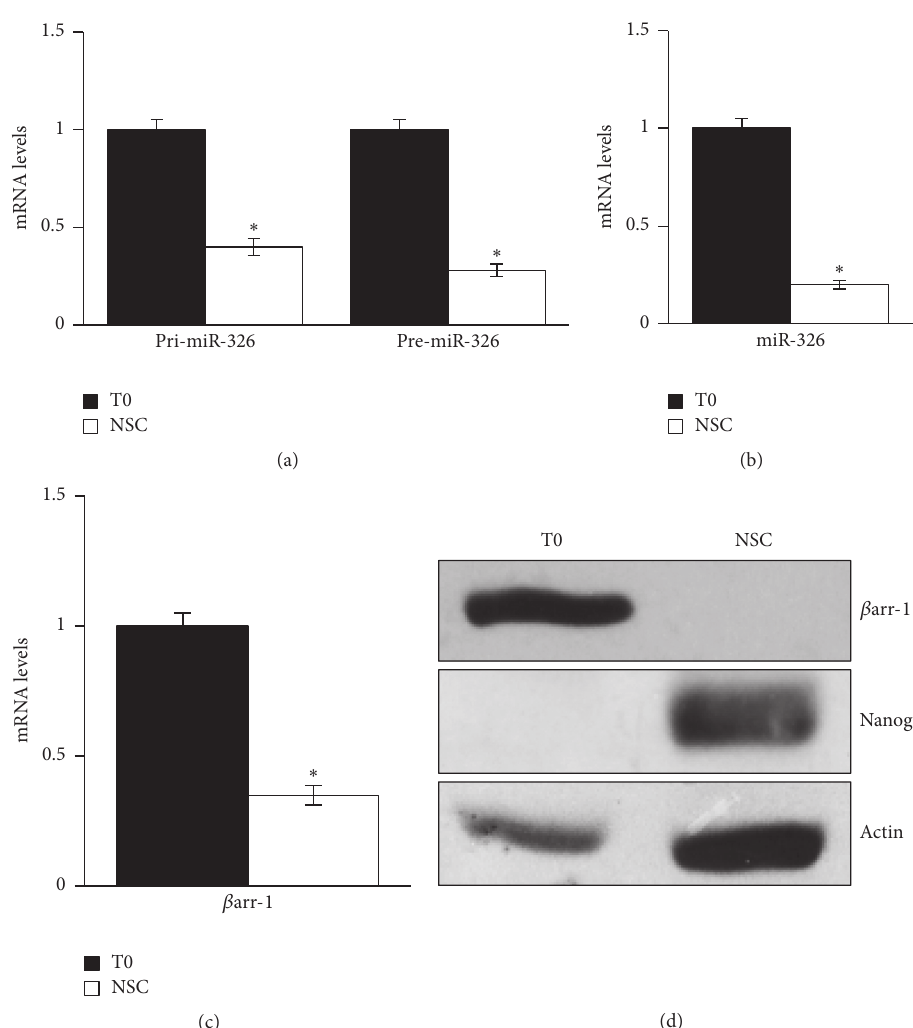
Figure 1: miR-326 and 𝛽 arr-1 are downregulated in cerebellar NSCs compared to the bulk cerebellar population. (a) mRNA expression levels of the primary (pri-miR-326) and precursor (pre-miR-326) of miR-326 in NSCs compared to bulk cells (T0). (b) Mature miR-326 levels in NSCs compared to bulk cells (T0). (c) 𝛽 arr-1 mRNA levels in NSCs compared to bulk cells (T0). (d) Western Blot (WB) analysis of endogenous 𝛽 arr-1 and Nanog in NSCs compared to bulk cells (T0). Actin as loading control (LC). (a)–(d) data are means ± SD from 3 independent experiments. ∗ 𝑝 < 0.05